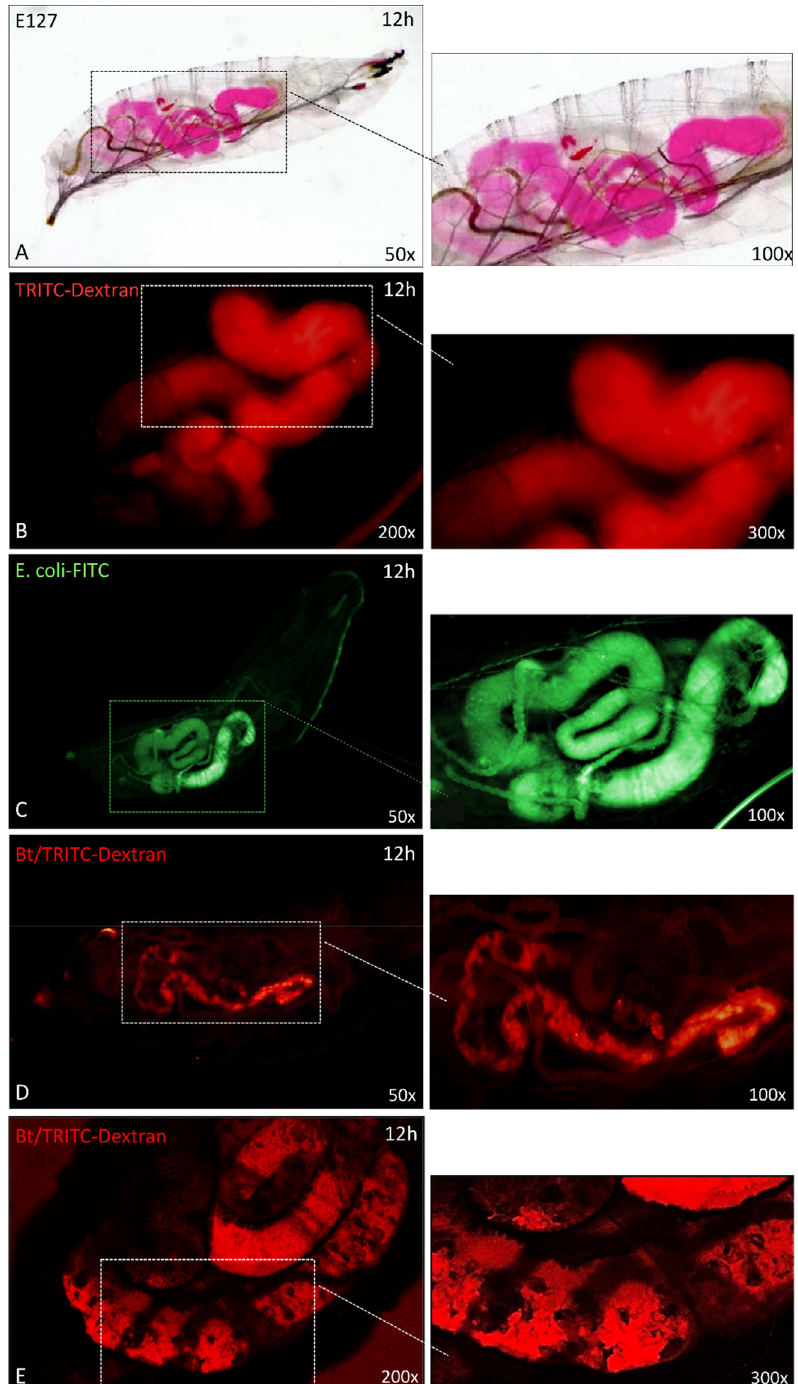
Figure 6. The morphology of SWD gut (L1 larval stages) after oral administration of Erythrosine (E127) ( A ), Dextran-TRITC ( B ), E. coli -FITC ( C ), and B. thuringiensis plus TRITC-Dextran ( D , E ). ( A , B ) show the anatomy of healthy larvae fed on Agar-Erythrosine or TRITC-Dextran; the staining highlights the morphology of the whole gut in healthy larvae. A regular morphology was also observed after ingestion of non-entomopathogenic bacteria E. coli FITC-conjugated ( C ). ( D , E ): the altered morphology of SWD gut after administration of B. thuringiensis plus TRITC-Dextran. After B. thuringiensis treatments the damage of the gut wall was highlighted by the presence of TRITC- Dextran. ( E ) is a confocal image of larvae after Bt/dextran treatment. Insets at right are enlargements of the